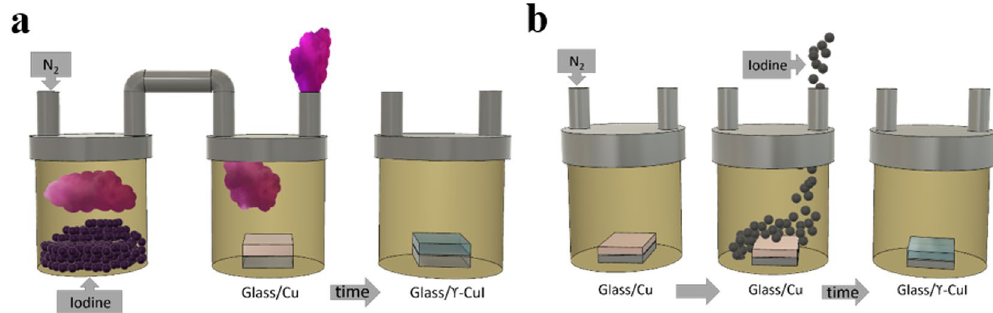
Figure 7. Schematic of the iodination process: ( a ) vapour phase; ( b ) solid